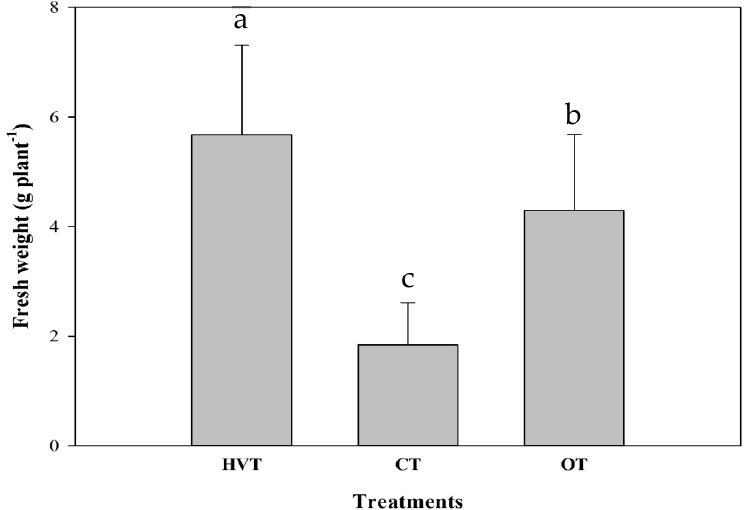
Figure 4. The mean fresh weight of whole plants for Pak choi for each treatment. The numeric values of the fresh weight were the average of the samples. Means followed by the same letter are not significantly different ( p < 0.05, Tukey multiple comparison tests). HVT is the high-temperature oscillation pattern, CT is the fixed temperature regime, and OT is the inside temperature of a net house. The length of the error bar is proportional to the standard error of the mean.